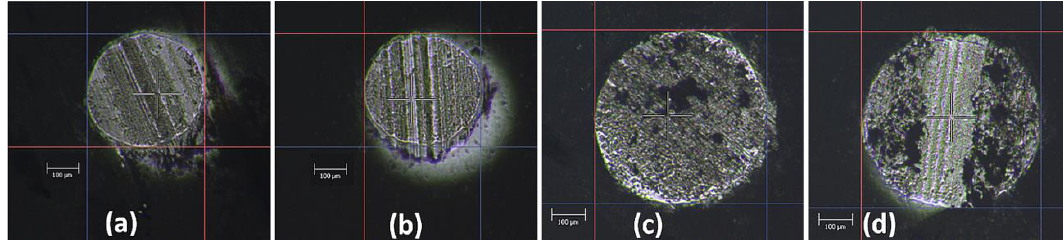
Figure 10. Wear of the counterpart, Al 2 O 3 ball, after the test with the coatings deposited from cathodes with silicon concentrations: ( a ) 1 at%, ( b ) 2 at%, ( c ) 5 at% and ( d ) 10 at%.